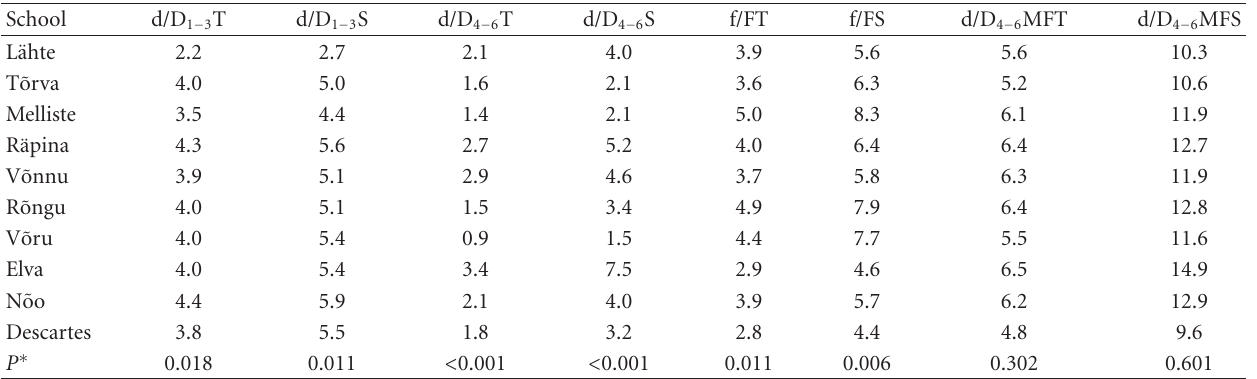
Table 5: The caries indices according to the